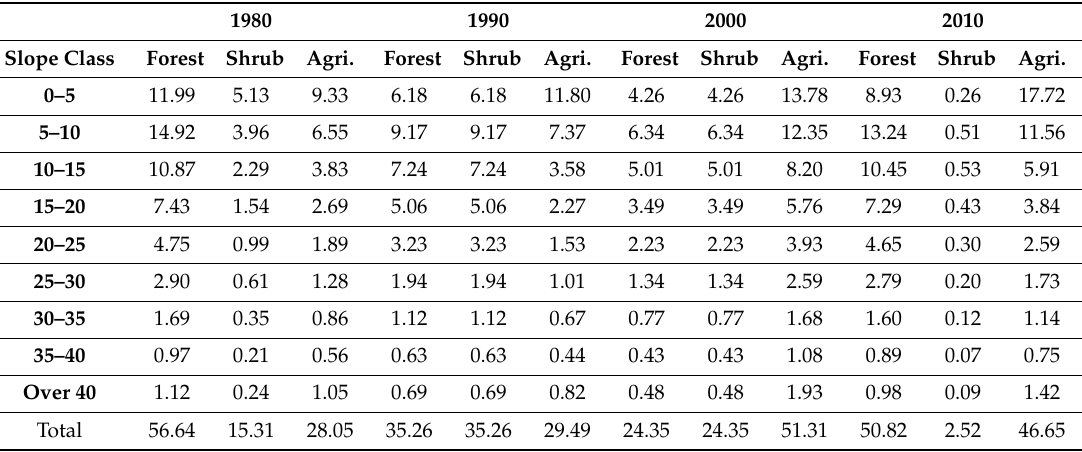
Table 11. Province 5: land use as a percentage of total area of forest, shrubland, and agriculture for 1980, 1990. 2000, and 2010 for entire Nepal. ((Individual land-use area for a slope class / sum of forest + shrubland + agriculture) * 100).